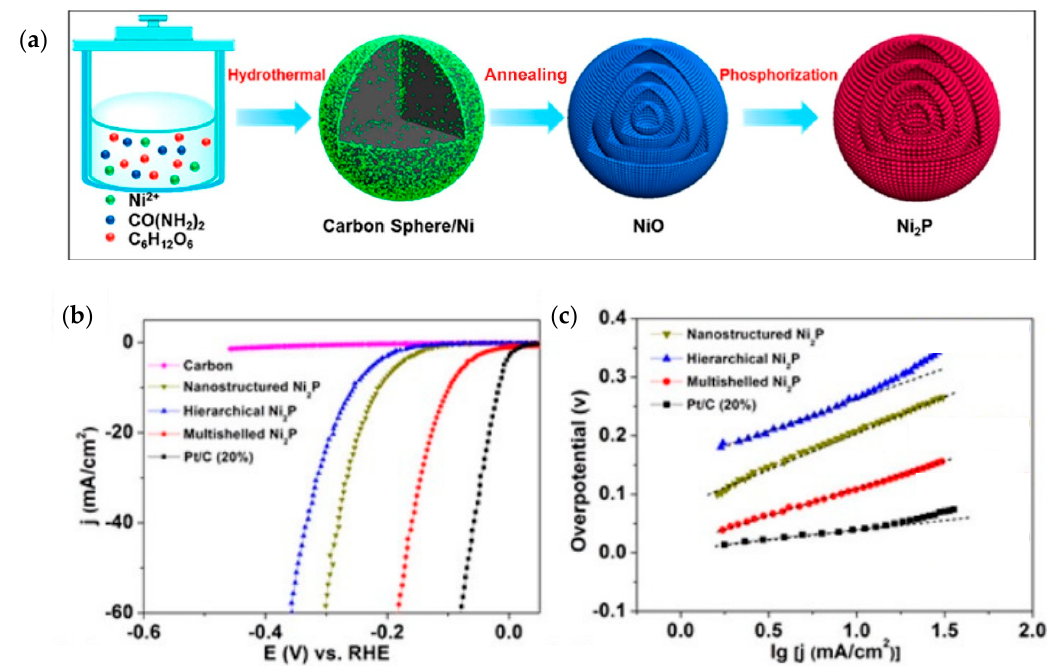
Figure 6. ( a ) Synthetic schematic illustration and material characterization of the multishelled Ni 2 P. ( b ) Linear sweep voltammetry (LSV) polarization curves of bare carbon, nanostructured Ni 2 P, hierarchical Ni 2 P, multishelled Ni 2 P, and benchmark Pt/C in 1 M KOH at a scan rate of 5 mV s − 1 . ( c ) Corresponding Tafel plots with linear fittings. Reprinted with permission from [120]. Copyright 2017 American Chemical Society.